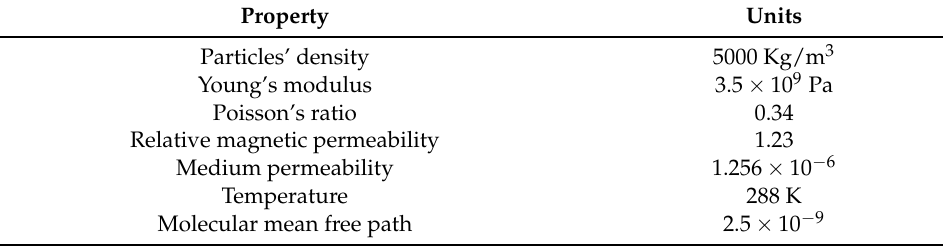
Table 3. Particles’ and simulations